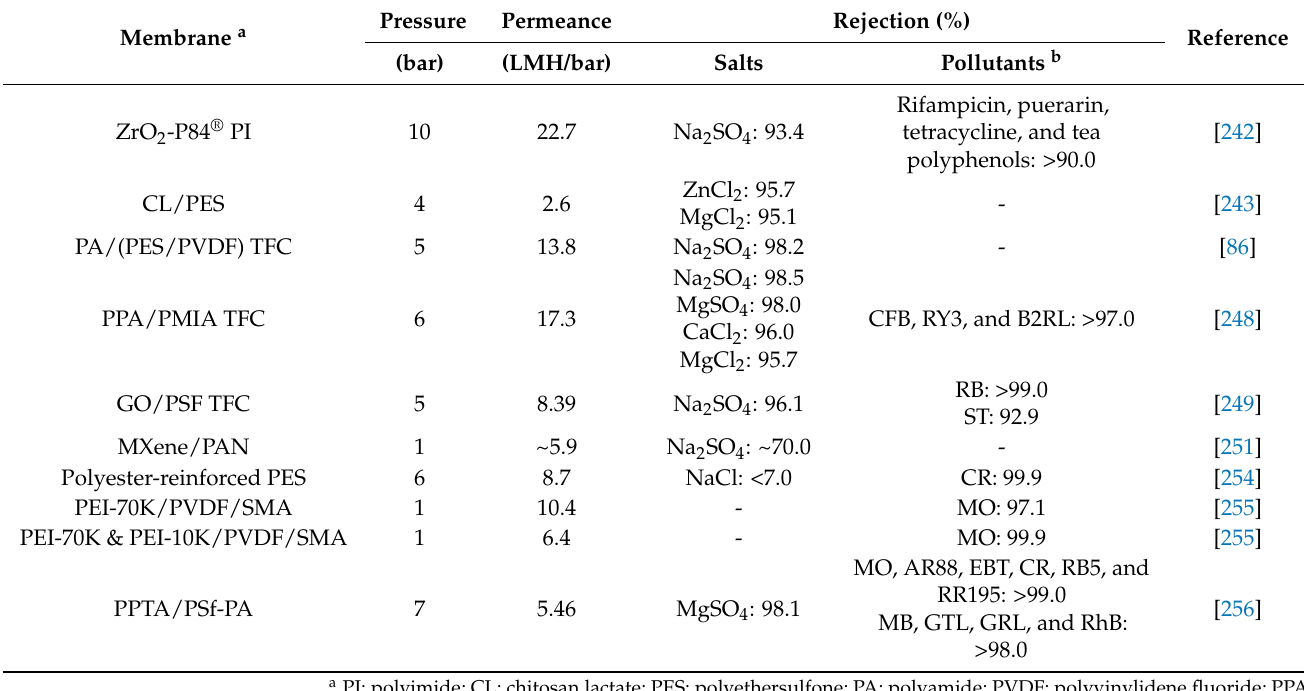
Table 1. Separation performances of hollow fiber membranes in NF.